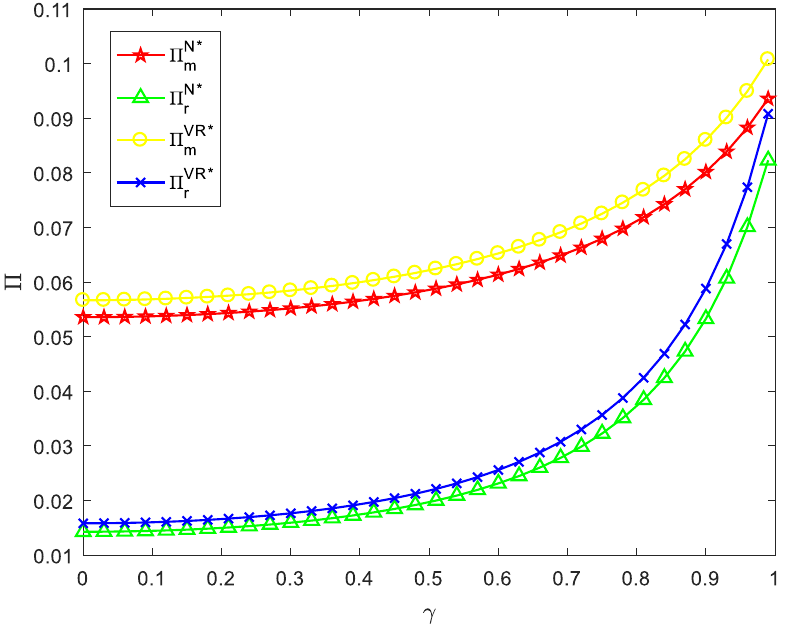
Figure 2. Profits of supply chain members under decentralized decision making.